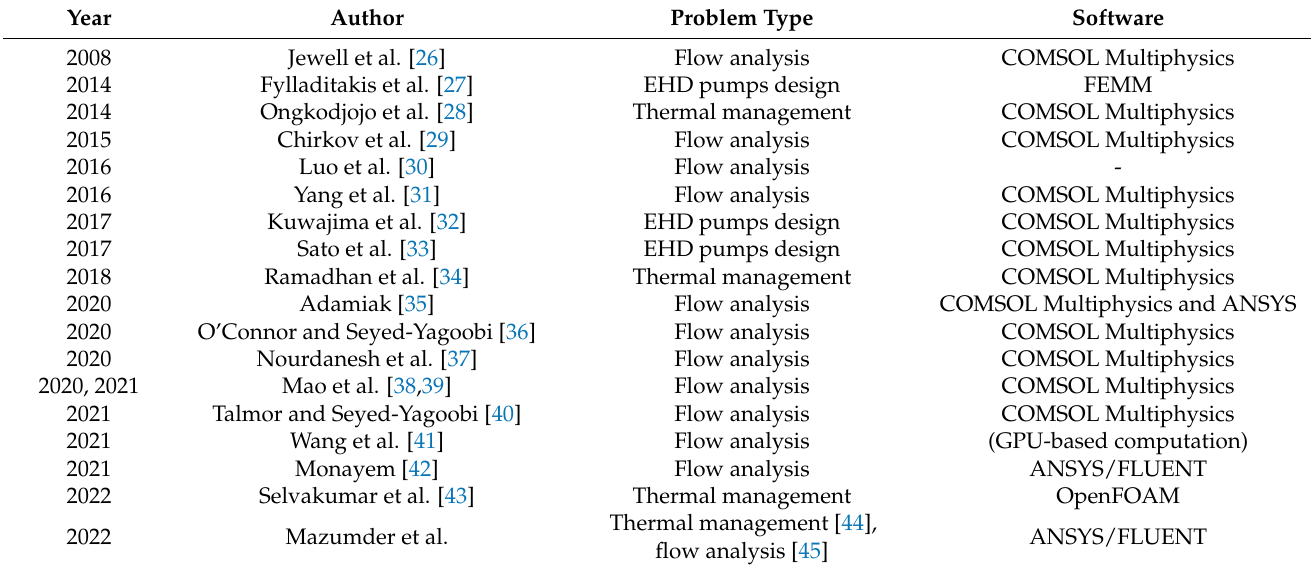
Table 1. Numerical methodology for fluidic EHD pump simulations in recent